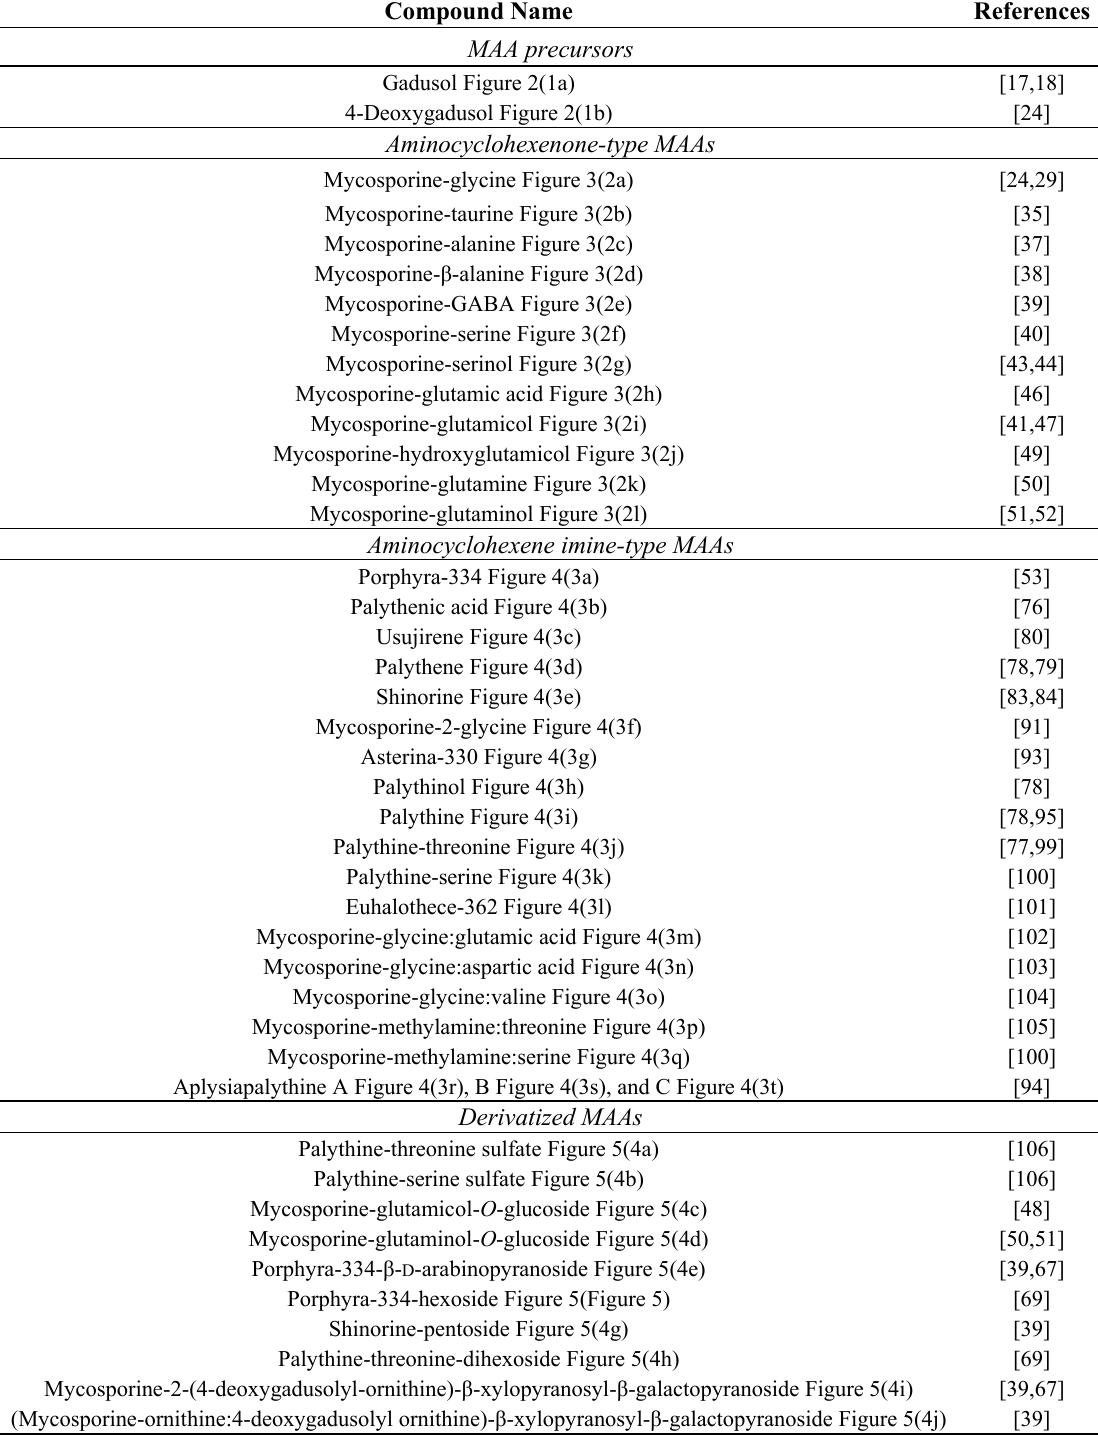
Table A2. Summary of the references to determine the chemical structure of each